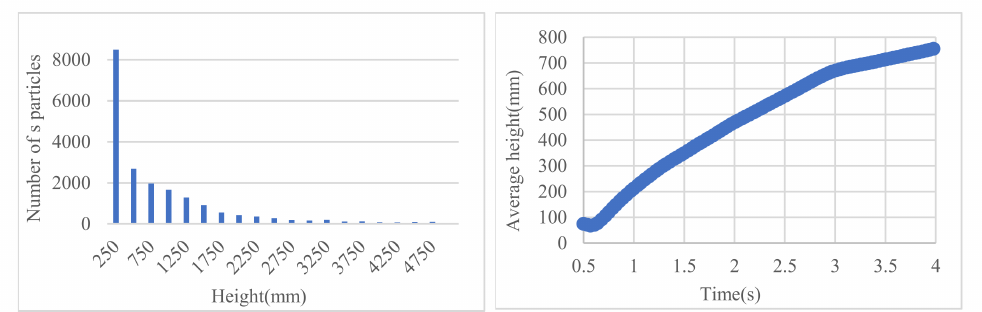
Figure 16. The number of particles by height at 4 s and the average height of particles in 4 s.